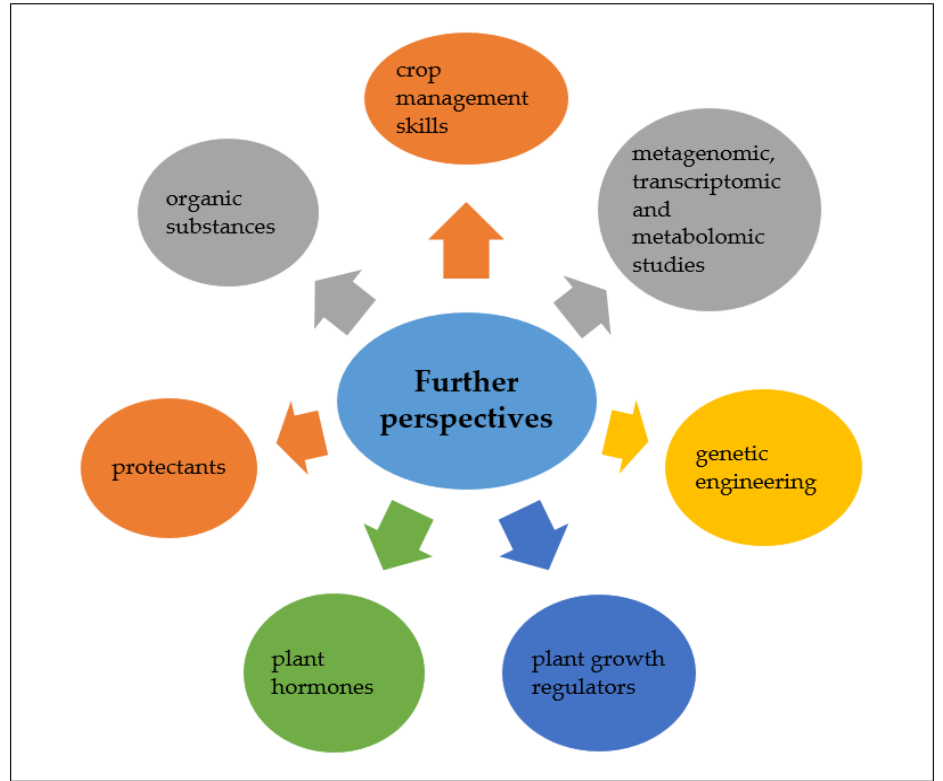
Figure 3. Future possible perspectives in order to mitigate drought stress.